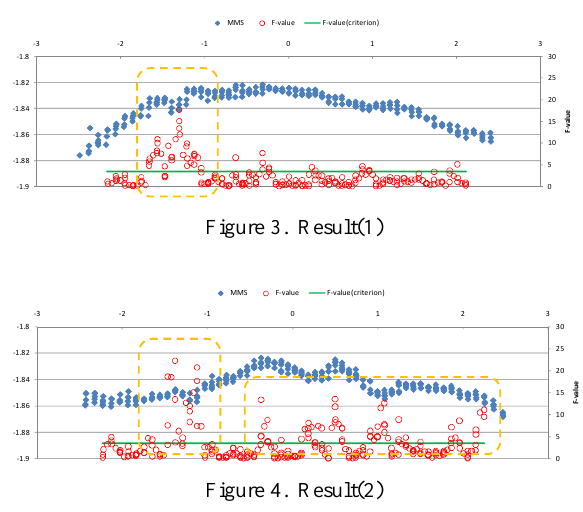
Figure 6. Comparison between Chow-Test and